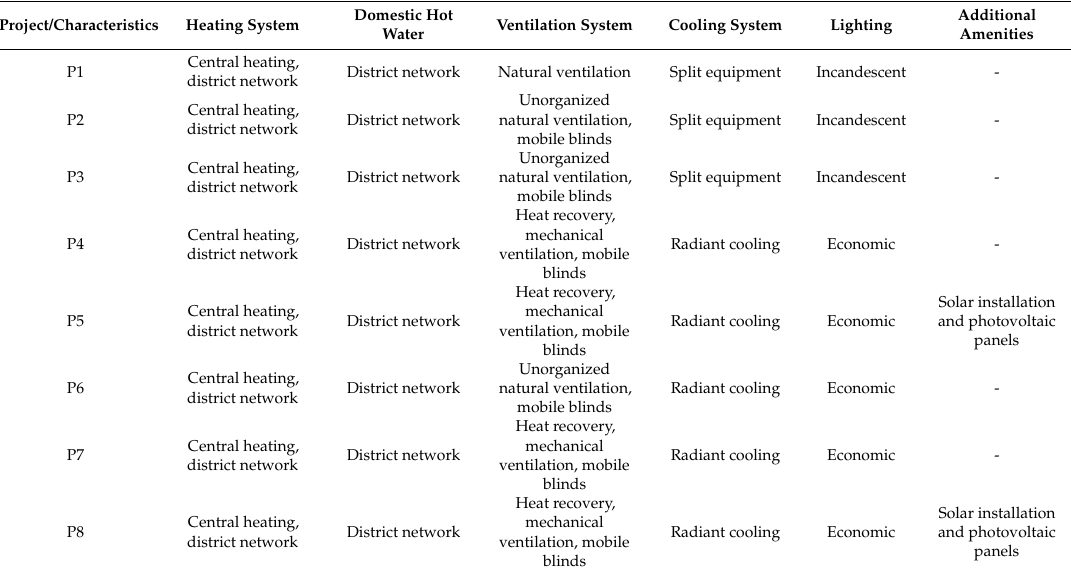
Table 1. The main characteristics of energy efficiency projects in the South-Muntenia region 1